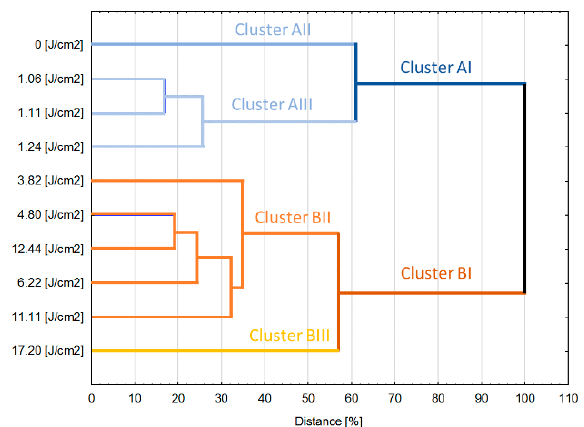
Figure 6. Results of the cluster analysis performed based on of all investigated variables.